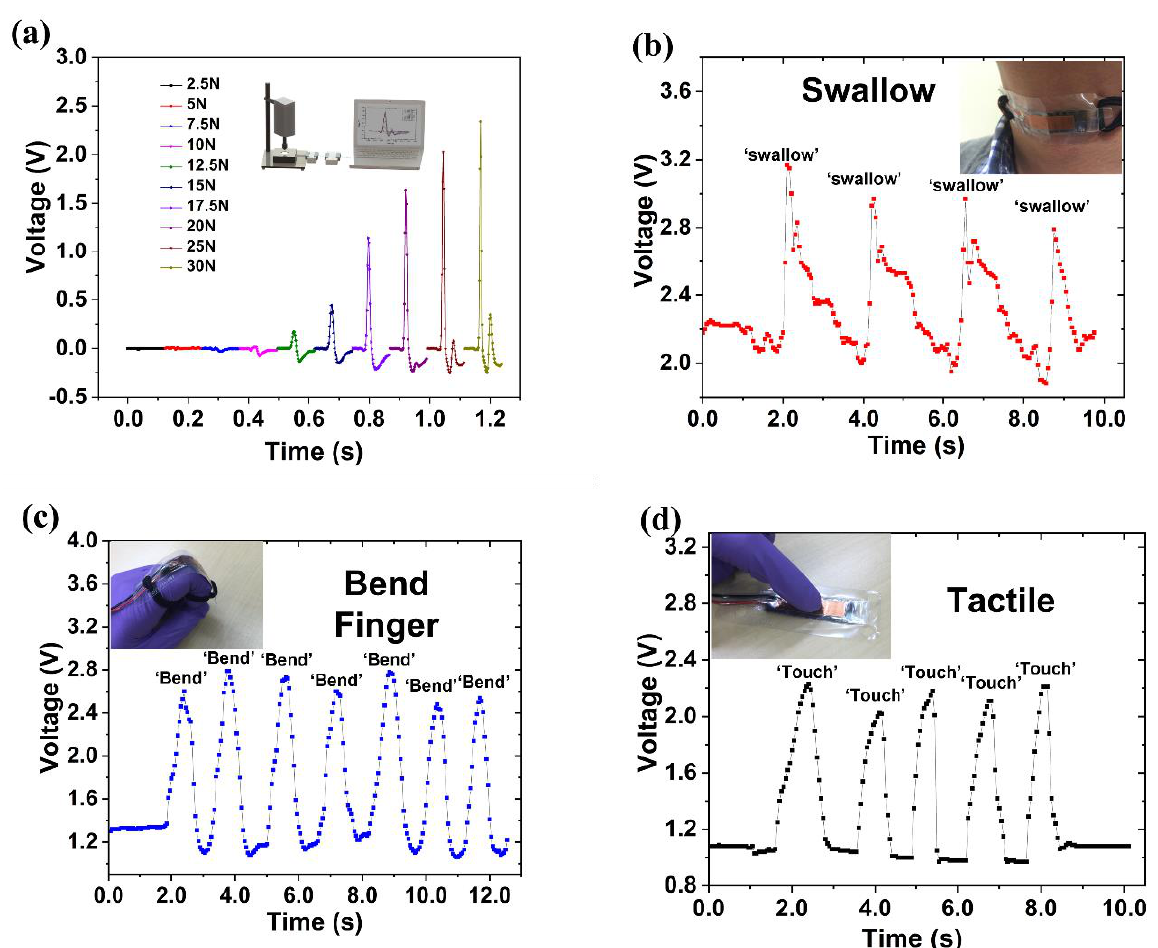
Figure 5. ( a ). The application of the COC piezoelectric sensor in measuring the impact events of real-time high-rate impacts. The sensing materials were placed on a soft PU foam support; ( b ). Real-time signal pattern of measuring the movement during swallowing, with the sensor directly attached to the tester’s neck; ( c ). The signal of the sensor in measuring the motion during finger bending; ( d ). Signal pattern corresponding to finger touch.